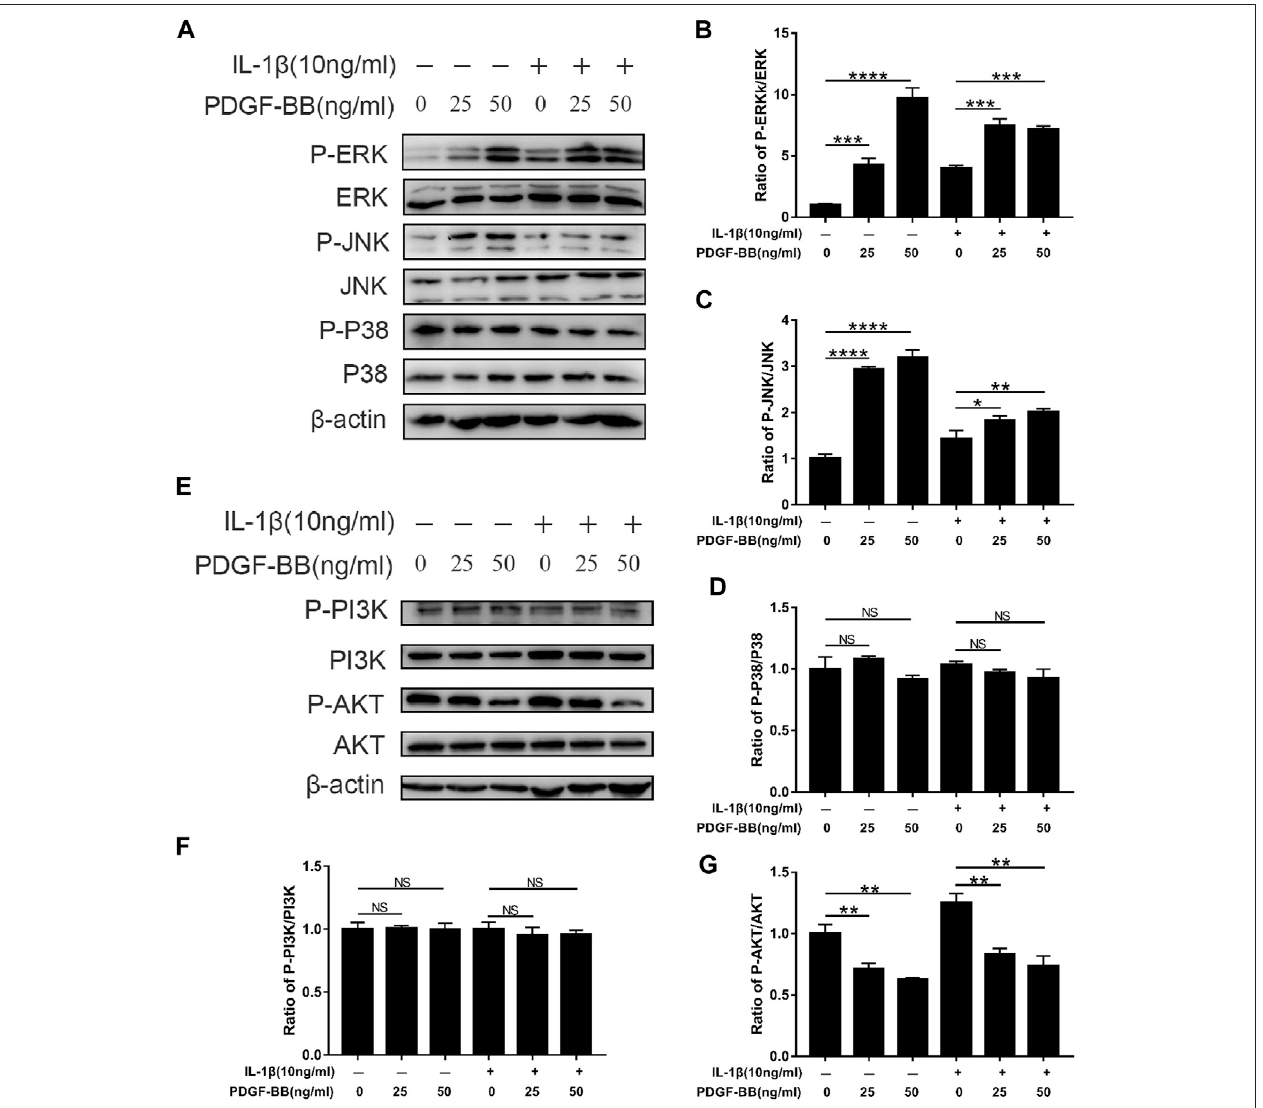
FIGURE 5 | Effects of PDGF-BB on the MAPK and PI3k/AKT pathway in IL-1 β -treated NPCs. (A – D) Western blot showed the PDGF-BB promotion effects on the phosphorylationofERKandJNK,butnotP38. (E – G) WesternblotshowedthePDGF-BBalleviationeffectsonthephosphorylationofAKT.AllNPcellsweretreatedwith or without IL-1 β (10 ng/ml) and PDGF-BB for 48 h. The results were quanti fi ed using ImageJ software. Data are presented as the mean ± SD. n (cid:1) 3. Signi fi cant differences between groups are indicated as **** p < 0.0001, *** p < 0.001, ** p < 0.01, * p < 0.05.